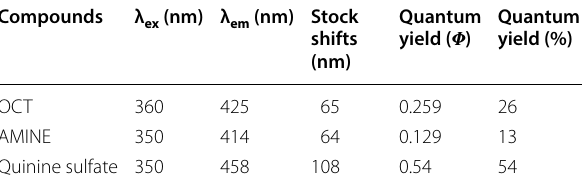
Table 5 Absorption and emission maxima and quantum yields ( Φ ) for OCT and AMINE compounds Compounds